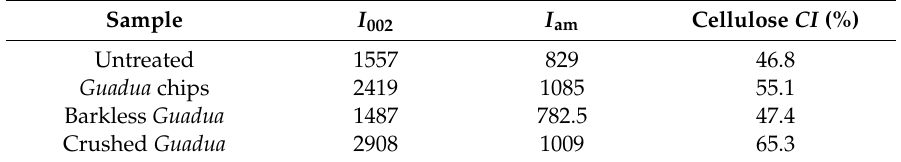
Table 2. Cristallinity index ( CI ) of cellulose in the Guadua samples, before and after Ca(OH) 2 treatment.